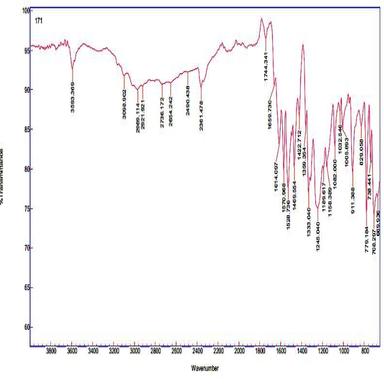
brational spectrum of FHM